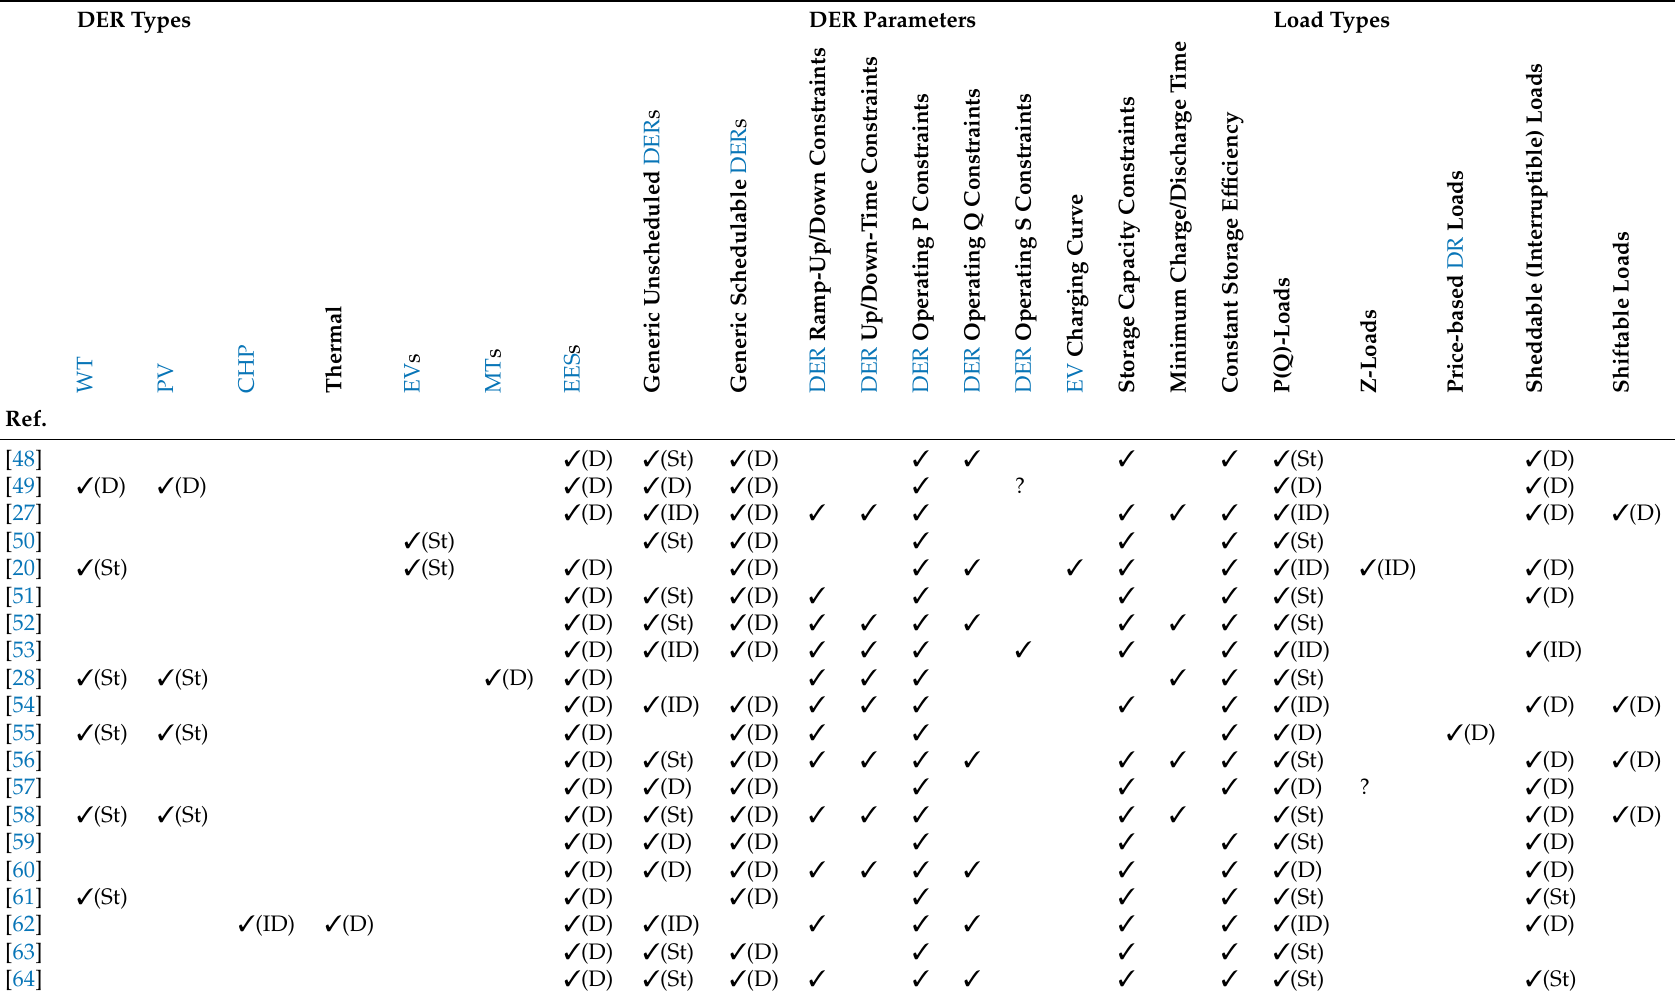
Table 3. Modeled load and DER types ( (cid:51) : Implemented, ?: Not reported, St: Stochastic, D: Deterministic, ID: Indeterministic) . DER